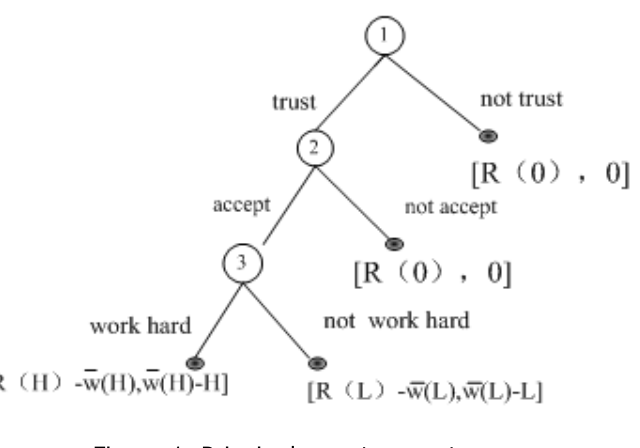
Figure 1. Principal-agent game